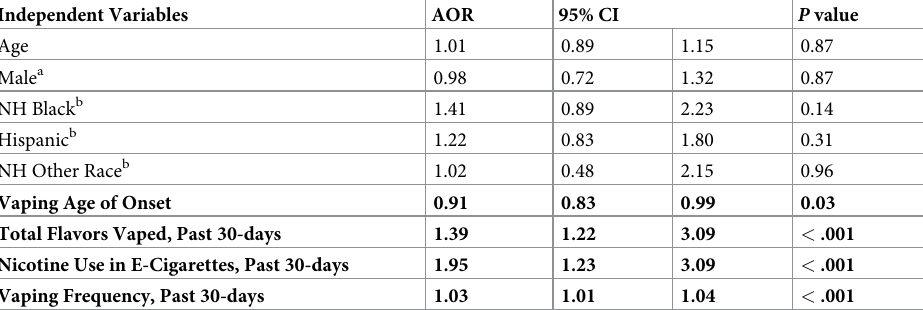
Table 2. Adjusted odds ratios for adolescents examining association with cooling